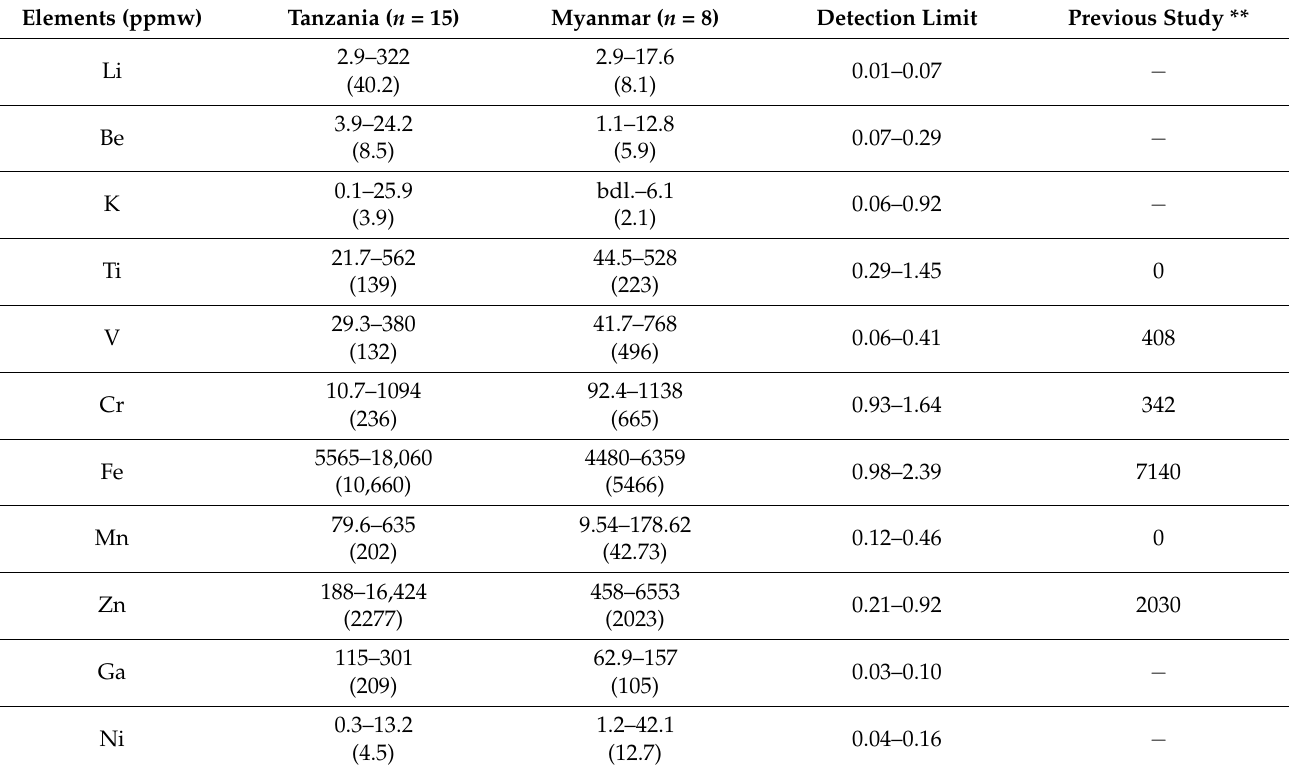
Table 2. Chemical composition by LA-ICP-MS of purple spinels from Tanzania and Myanmar *.